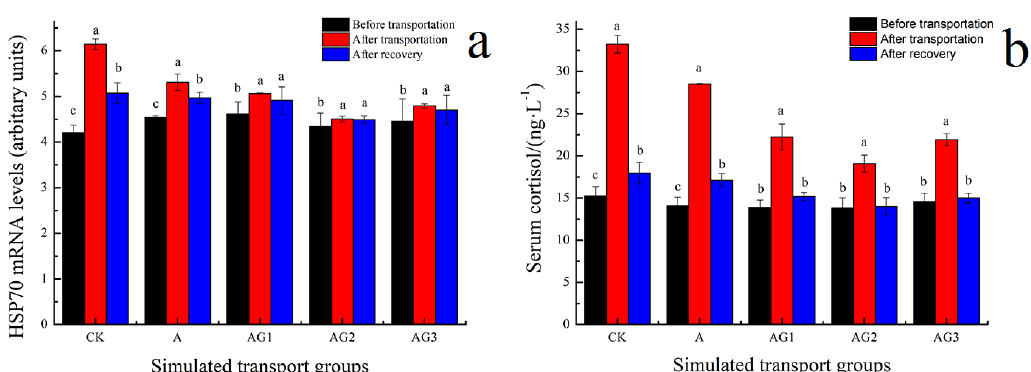
Figure 5. Effect of ascorbic acid and β-1,3-glucan addition on HSP70 ( a ) and serum cortisol ( b ) of tiger grouper during simulated transport. Among different treatments transport groups, different small letters indicate the results of Duncan’s test at different transport time. The same letters mean no significant difference ( p > 0.05), while different letters mean significant difference ( p < 0.05). Different letters without * = p- value < 0.05, different letters with ** = p- value < 0.01.